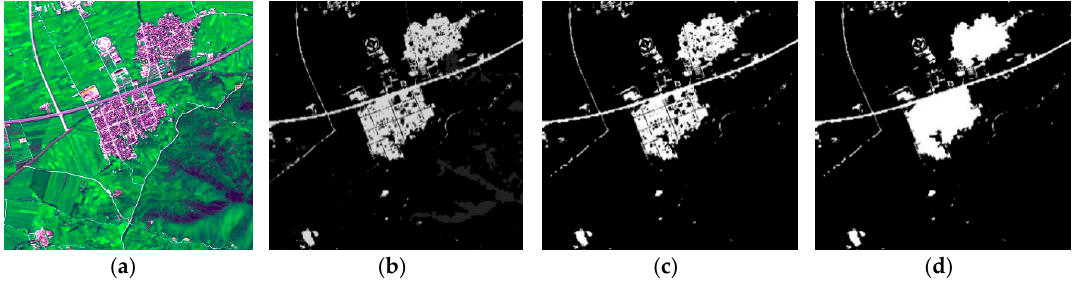
Figure 7. The generation and simple hole-filling of an ROI mask. ( a ) Original image; ( b ) Joint multi-image saliency map; ( c ) ROI mask; ( d ) filled ROI mask.